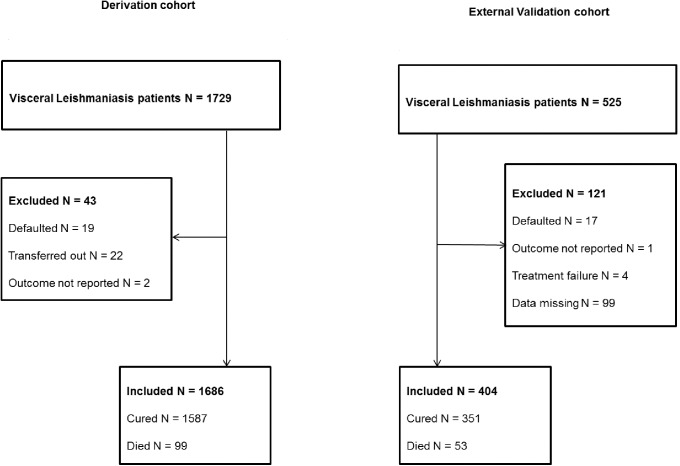
Flow diagram showing the number of patients in the study and their outcomes.